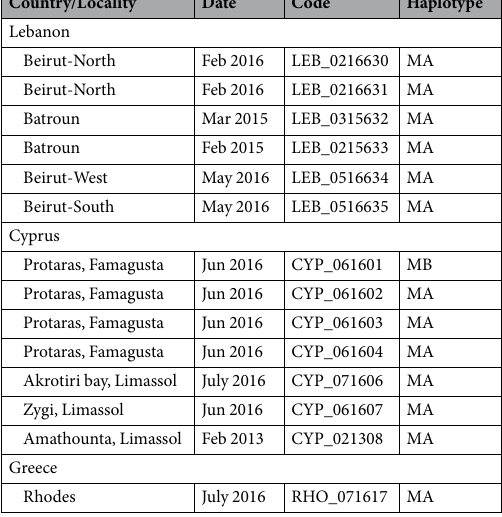
Table 1. Sampling localities, dates sampled, codes used and haplotypes of the lionfish Pterois miles in the Mediterranean